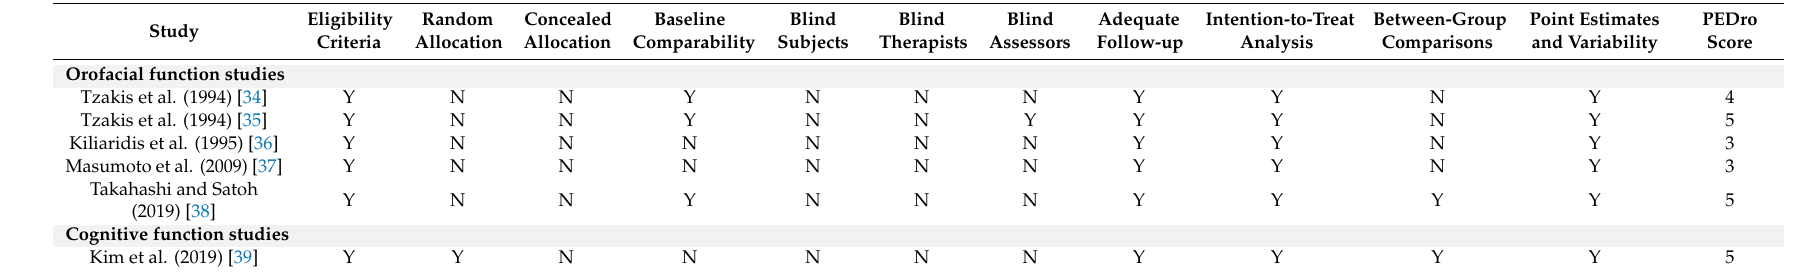
Table 4. Description of studies quality based on Physiotherapy Evidence Database Scale